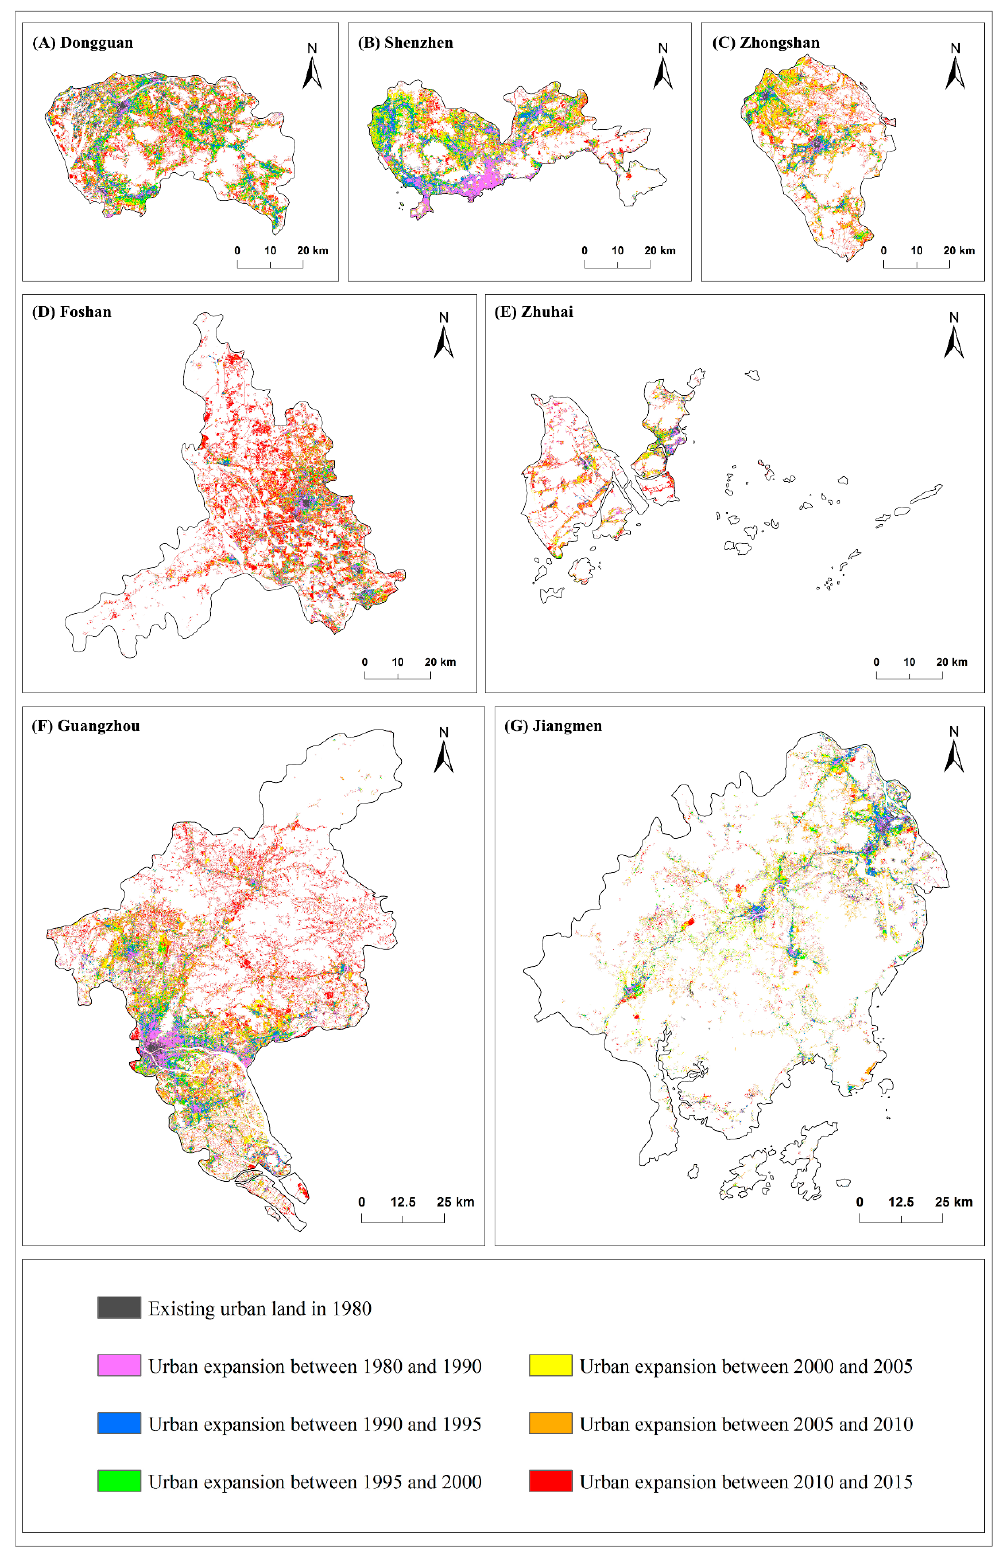
Figure 2. The spatial distribution of urban extent of seven cities from 1980 to 2015: (A) Dongguan, (B) Shenzhen, (C) Zhongshan, (D) Foshan, (E) Zhuhai, (F) Guangzhou, (G) Jiangmen. Dark grey represents the location of existing urban land at the initial study period and the distribution of newly urbanized areas are displayed in colors with 5–year intervals.